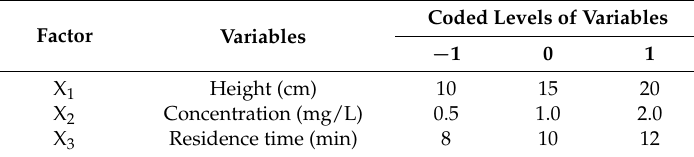
Table 1. The experimental range and levels of design of the experiment.